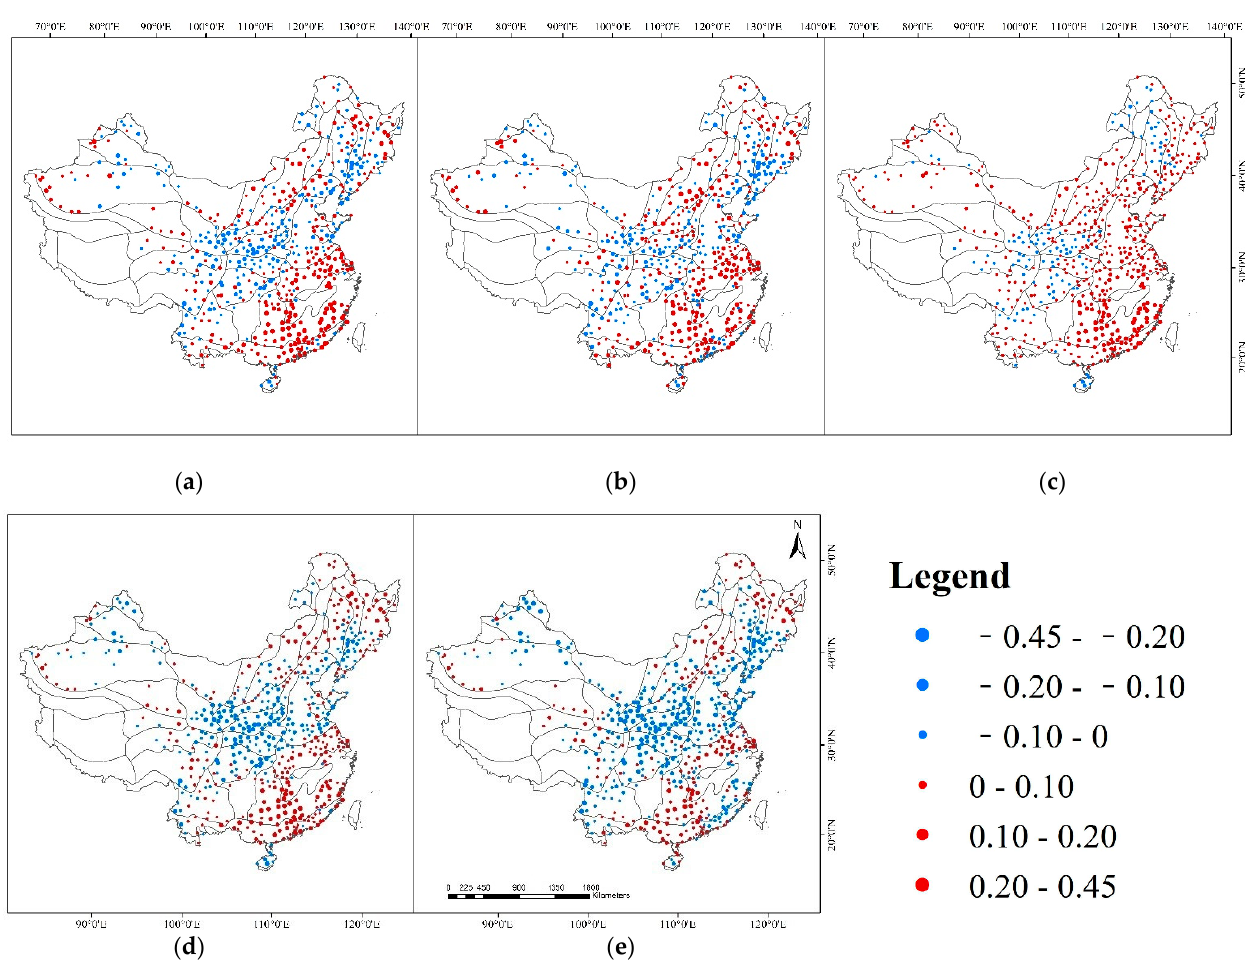
Figure 5. Correlation between the meteorological drought indices and Niño 3.4 (except the South China Sea Islands): ( a – e ) spatial distribution of the correlation coefficient between PDSI, SC_PDSI, SPEI- 1, SPEI- 6, SPEI- 12 and Niño 3.4.